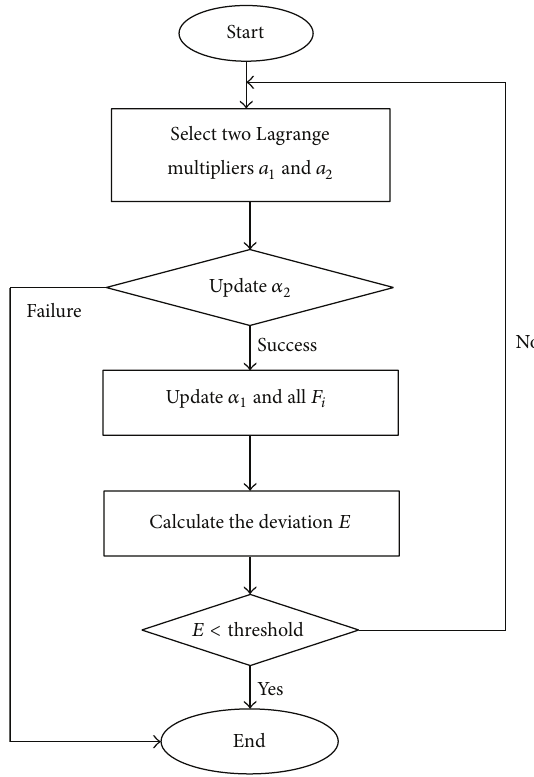
Figure 2: Procedures of the SMO training